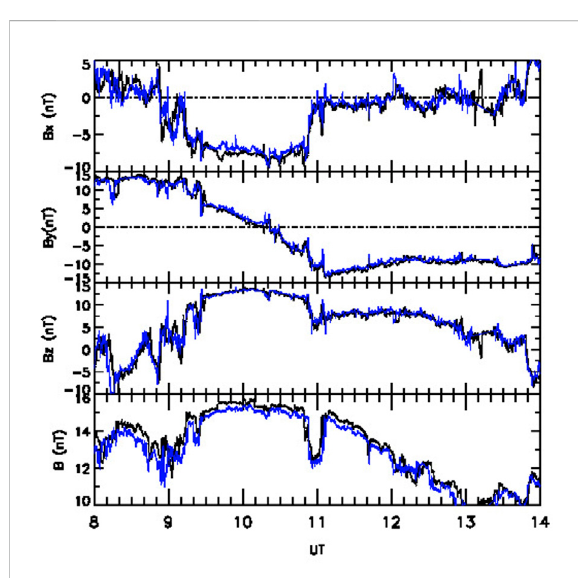
FIGURE 5 An overlay of ACE (black) and Geotail (blue) magnetic fi eld data. ACE data are delayed by 46